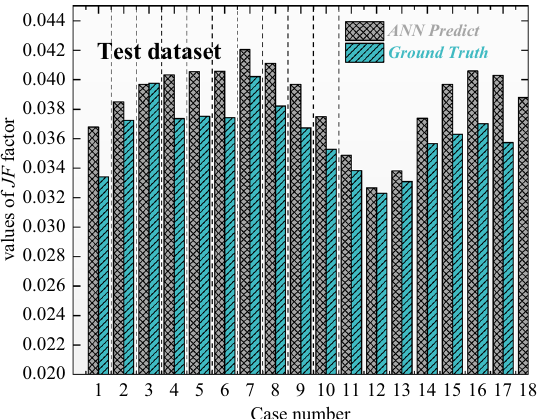
Figure 14 Comparison of predicted and actual values of the JF